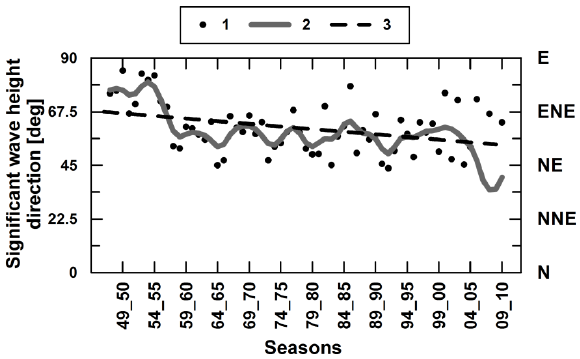
Figure 11. Variability of average direction of wave propagation during 1948-2010. Downward 2 Fig. 11. Variability of average direction of wave propagation during trend indicates northward shift in the predominant wave direction; 1 – data points, 2 – LPF 3 1948–2010. Downward trend indicates northward shift in the pre- dominant wave direction; 1 – data points, 2 – LPF approximation, approximation, 3 – global linear trend (2.21 deg/decade, R 2 =0.13) 4 3 – global linear trend (2.21degdecade − 1 , R 2 = 0 .